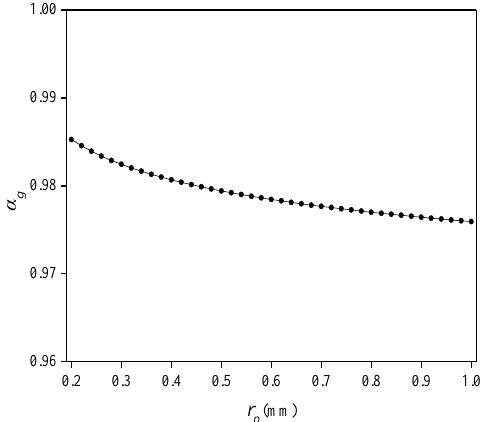
Figure 11. Relationship between radius of groove and average strain-transfer coefficient.